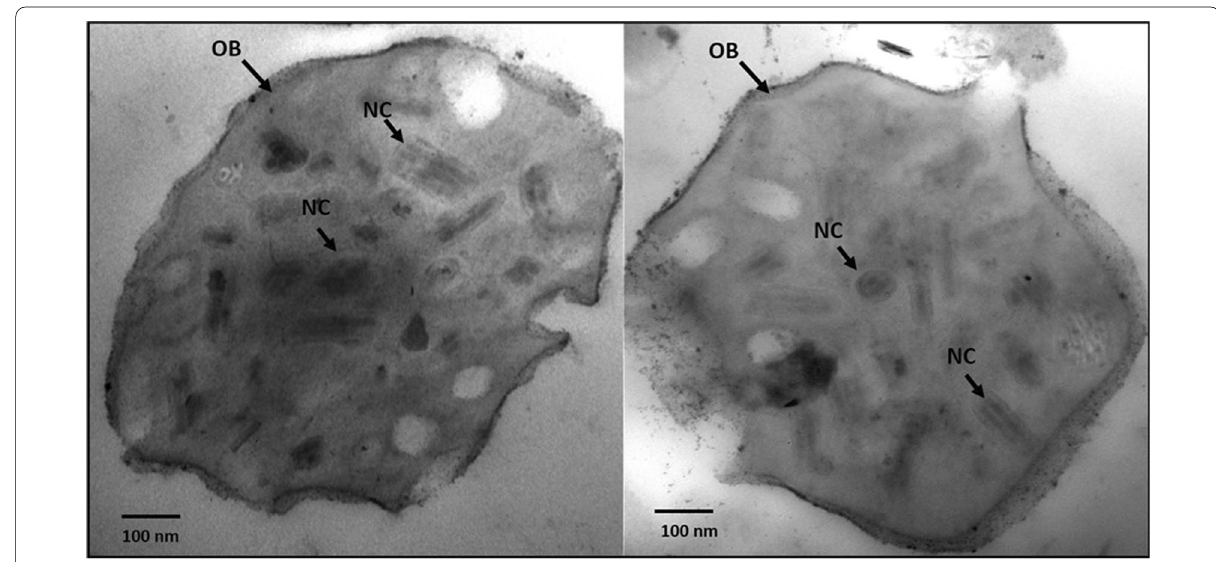
Fig. 2 Transmission electron micrographs of ultrathin section of obs obtained from nucleopolyhedrovirus infected Spodoptera littoralis larvae (magnification 148000 ), showed single and multiple nucleocapsid (NC) scattered in the Occlusion Body = ×